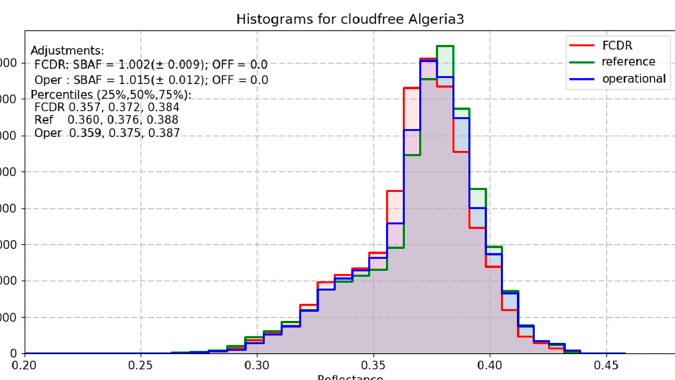
Figure 14. Histogram of SEVIRI HRVIS plotted as reference together with the histograms of the operational MVIRI dataset and the recalibrated MVIRI FCDR, as obtained from entirely cloud- covered pixels at 12:00 UTC slots during March 2005. Clouds are classified into high clouds ( a ), middle clouds ( b ) and low clouds ( c ). The MVIRI datasets were band adjusted to the SRF of the SEVIRI HRVIS band according to the given SBAFs. For each cloud-class the SBAFs for the operational dataset and for the FCDR are computed on the same set of SCIAMACHY spectra and the difference between both SBAFs is entirely due to the different shapes of the SRFs in the operational dataset and the FCDR.